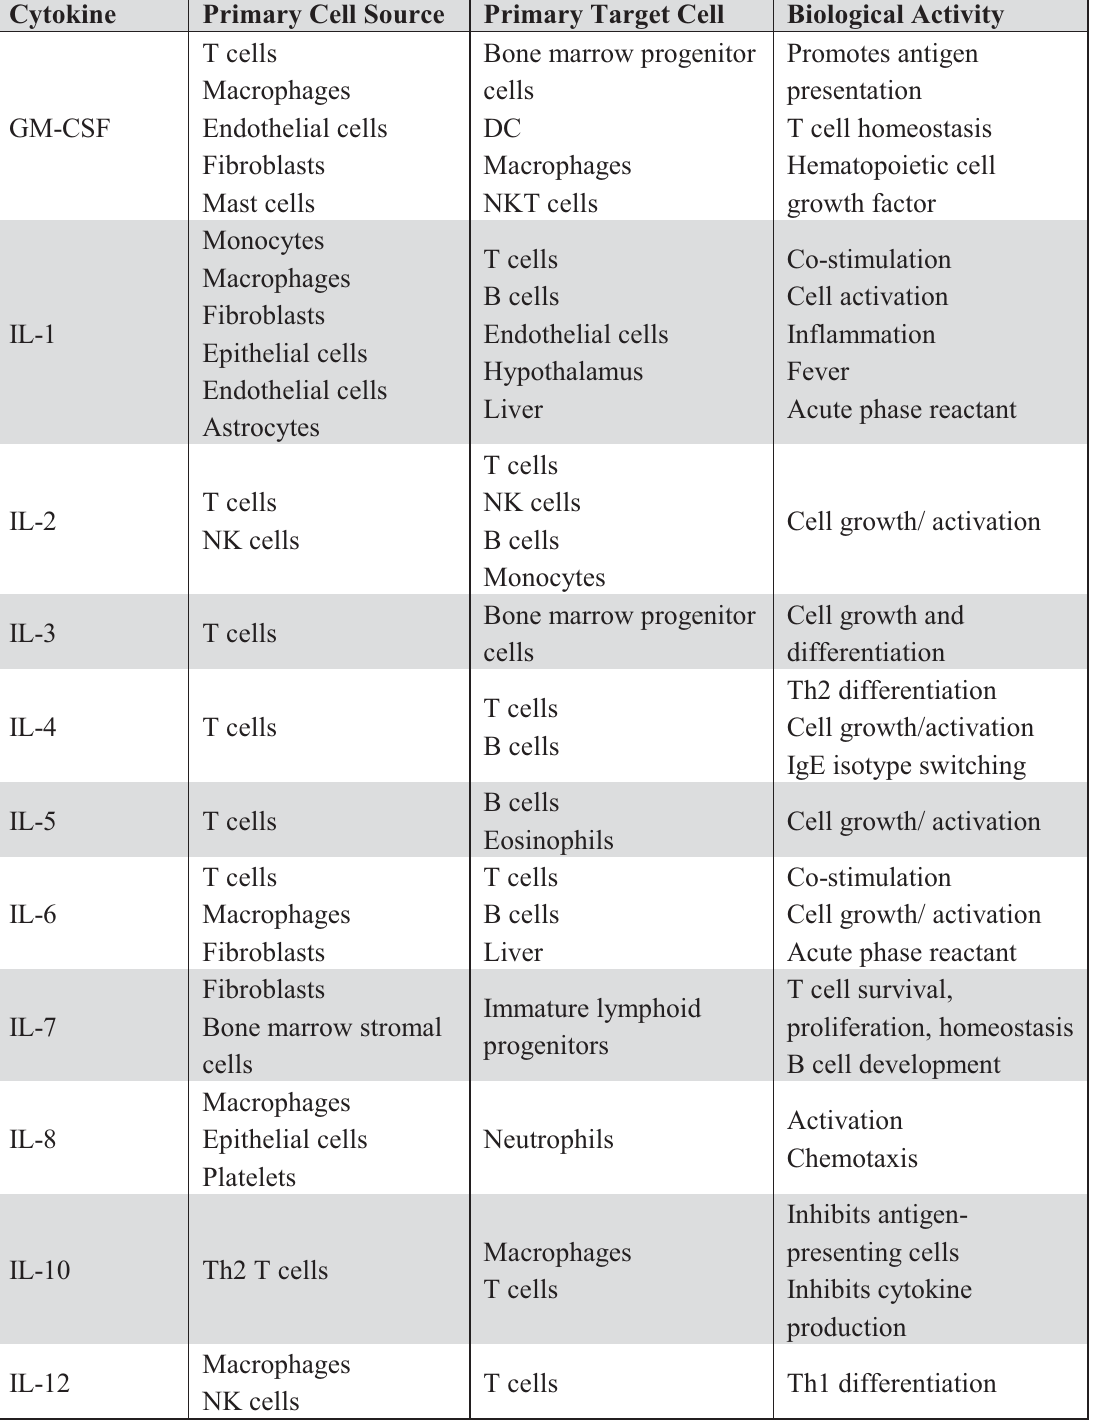
Table 1. General features of